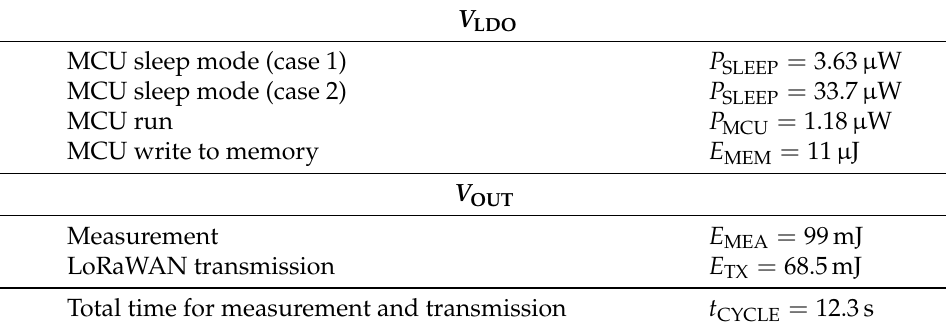
Figure 10. Experimental setup with MCU, LoRaWAN module and energy source. Table 6. Load parameters of the system